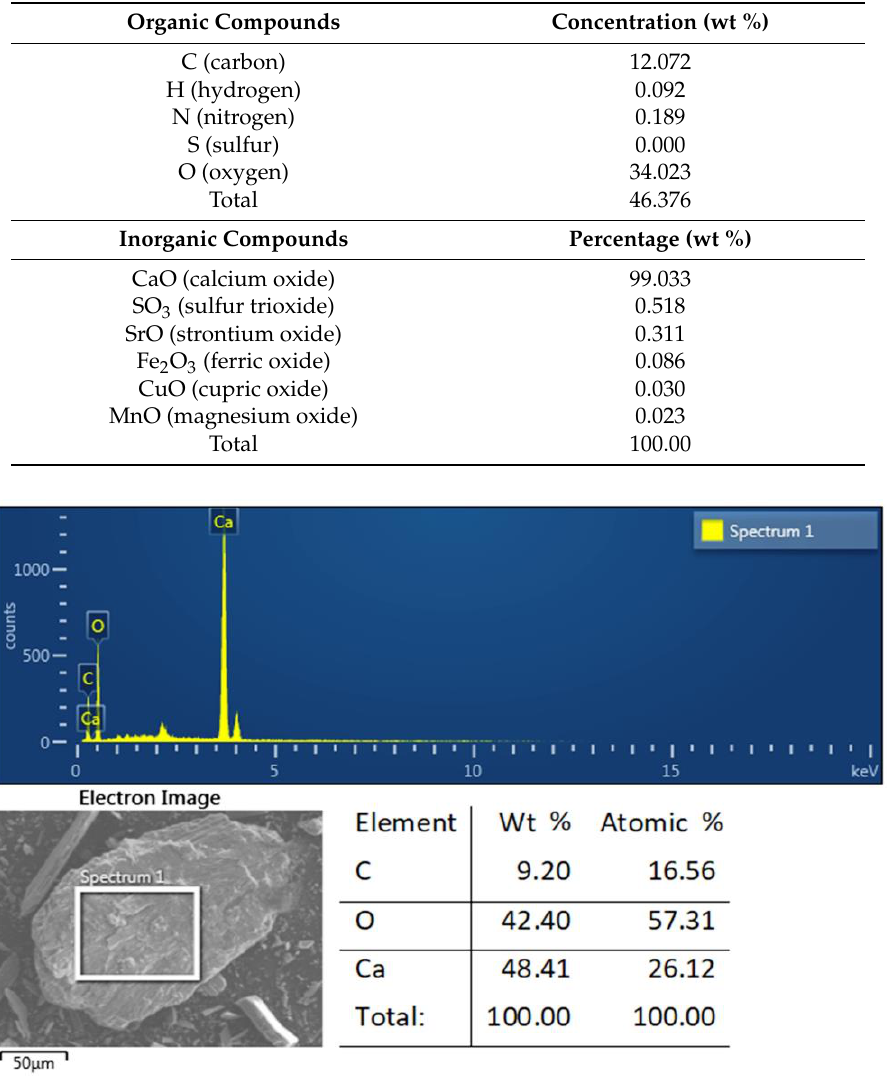
Figure 2. Scanning electron microscopy (SEM) with energy-dispersive spectroscopy (EDS) microanalysis for oyster shell powder (OSP).